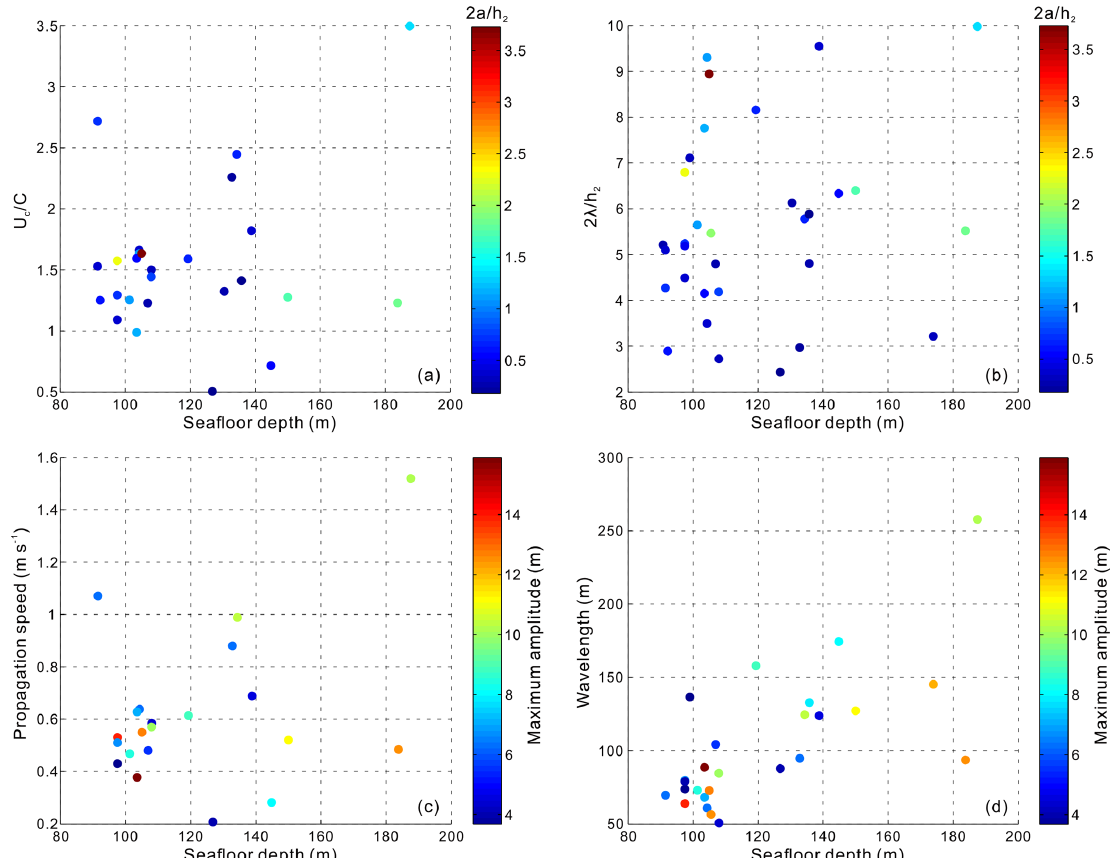
Figure 13. (a) Relationship between dimensionless propagation speeds and seawater depths of the mode-2 ISWs observed in the study area. The color of the filled circle indicates the dimensionless amplitude. (b) Relationship between dimensionless wavelengths and seawater depths of the mode-2 ISWs observed in the study area. The color of the filled circle indicates the dimensionless amplitude. (c) Relationship between propagation speeds and seawater depths of the mode-2 ISWs observed in the study area. The color of the filled circle indicates the maximum amplitude. (d) Relationship between wavelengths and seawater depths of the mode-2 ISWs observed in the study area. The color of the filled circle indicates the maximum